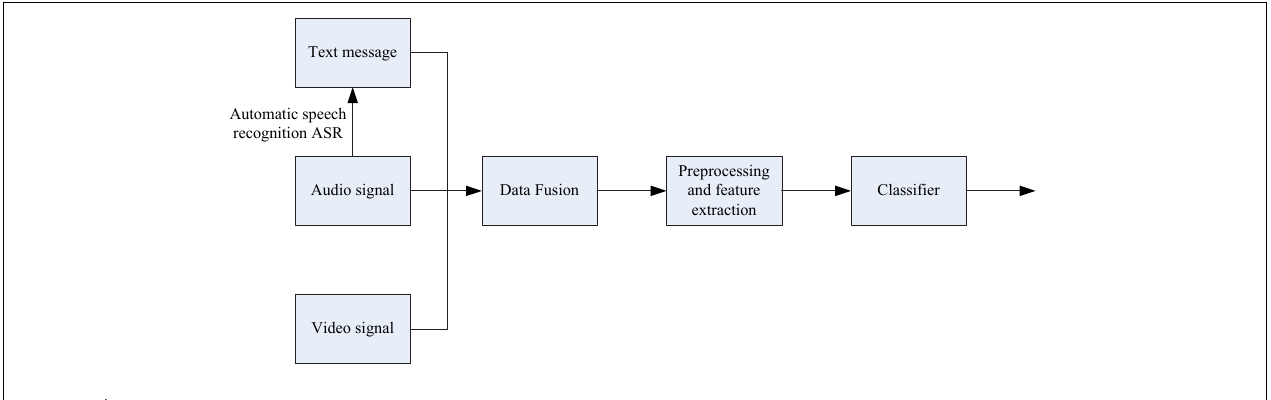
FIGURE 1 | Data layer fusion flow chart.